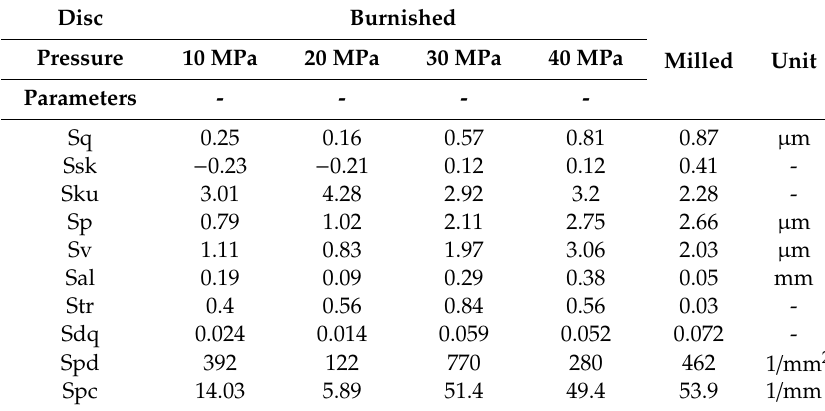
Table 3. Parameters of disc textures.